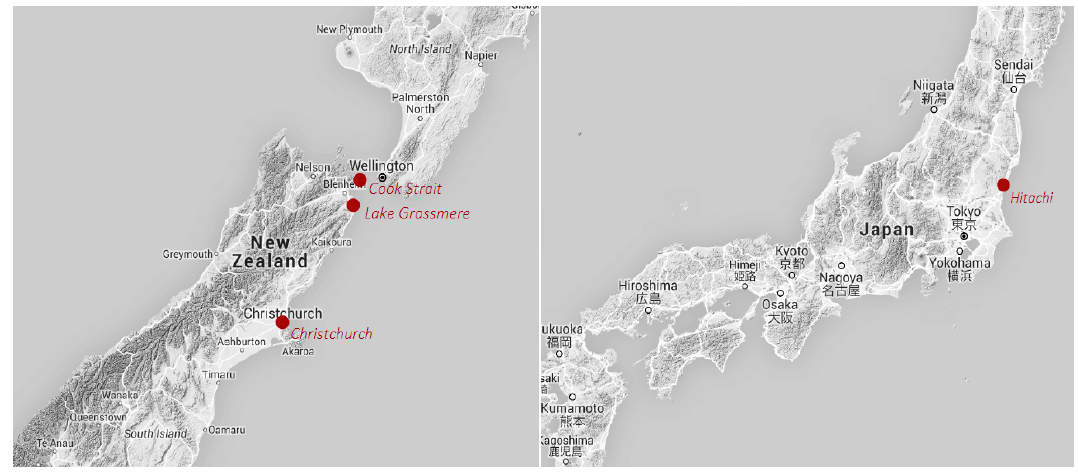
Figure 1. Earthquake survey locations.